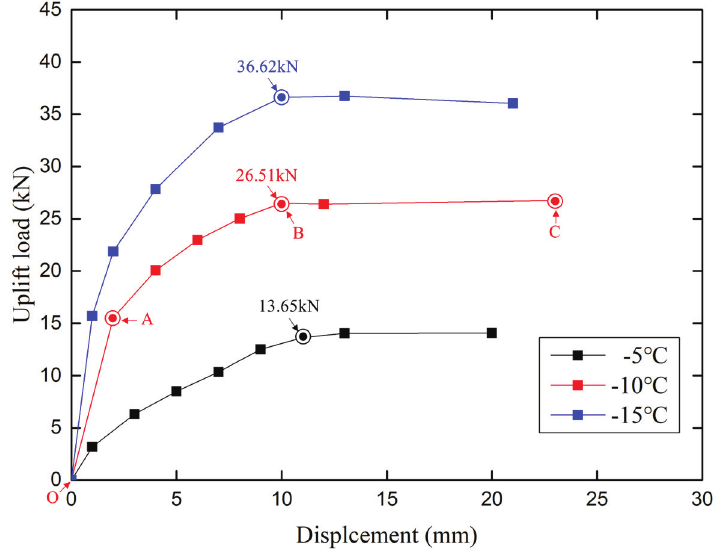
Figure 9. The uplift load versus displacement curves at three freezing temperatures.